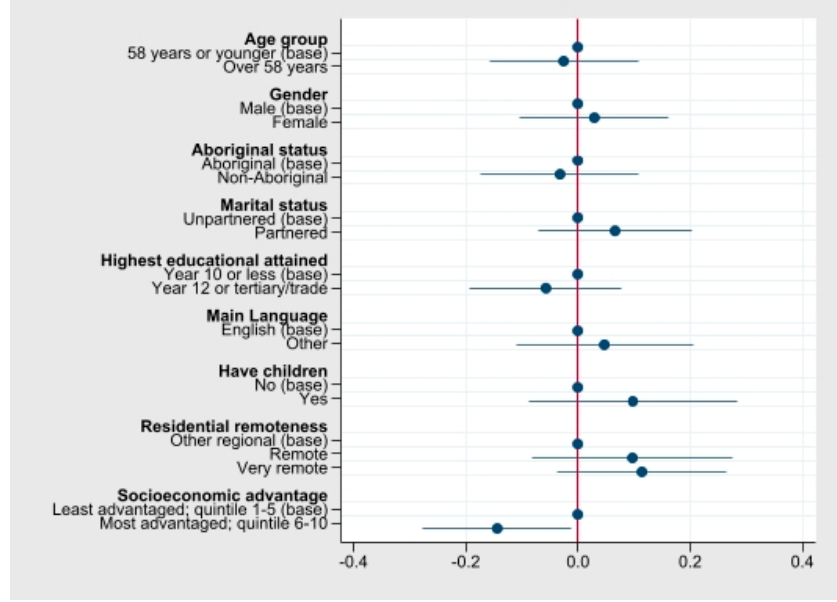
Figure 1. Crude associations between AQoL-4D utility scores and participant socio-demographic characteristics in cancer survivors (n = 63) in the first year of diagnosis, NT, Australia.